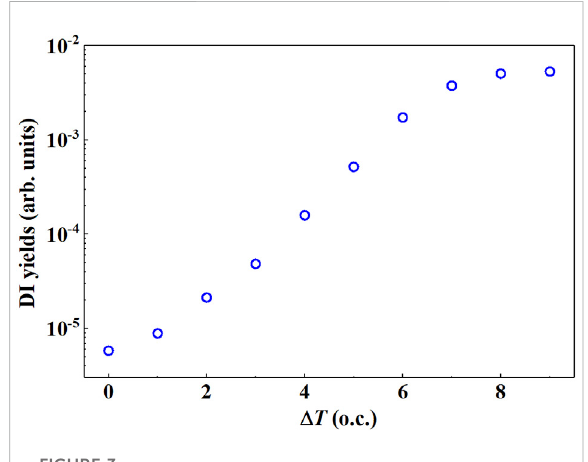
FIGURE 3 Relationship between double ionization yield and